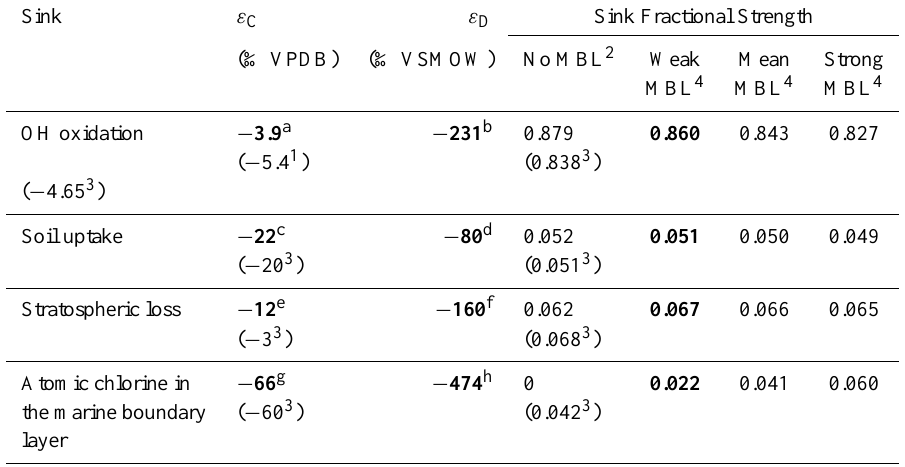
Table 1. Carbon and hydrogen isotope fractionation factors and proportional strength values for the CH 4 sink terms used in the mass balance calculations. The standard scenario with a weak MBL is denoted in bold font. Alternative values tested are shown in